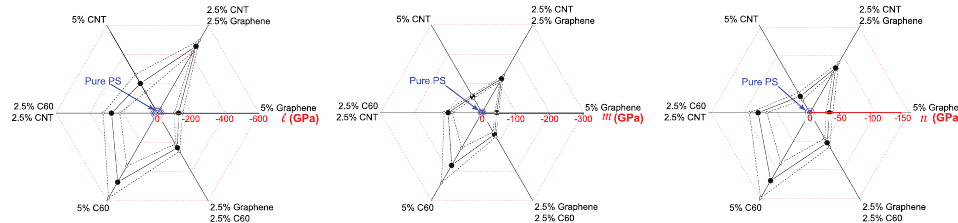
Figure 7. Representation of the data on measured nonlinear elastic moduli ( l , m , n ) of the pure polystyrene sample (shown in blue) and polystyrene with the addition of single-type inclusions (graphene, C 60 , CNT) and binary mixtures (C 60 + Gr, C 60 + CNT, CNT + Gr) of nanoparticles. Both measured values (filled circles and bold lines) and 68% confidence intervals (dashed lines and empty circles) are indicated. The graphs clearly show a significant increase in nonlinear elastic properties of all the composites over pure PS. It is also clearly seen that the nonlinear elastic moduli of samples with binary fillers are not equal to the average values of those of samples with single-type